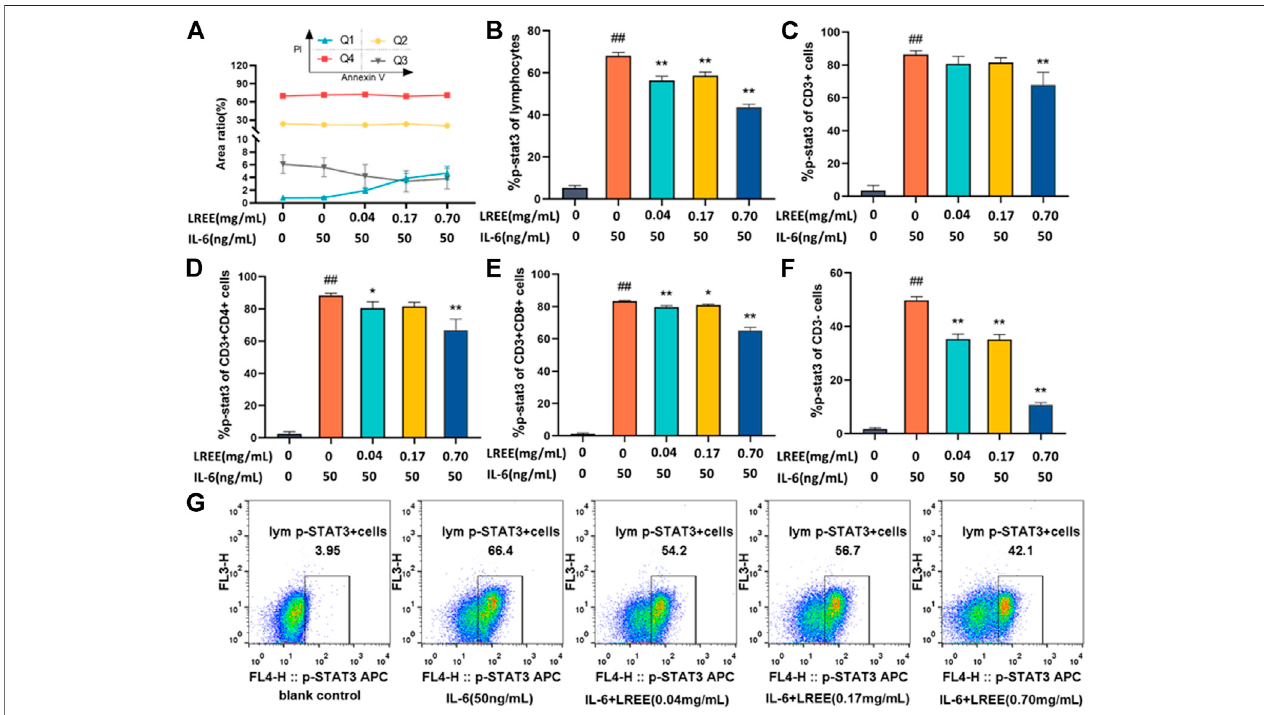
FIGURE7| EffectsofLREEonthephospho-STAT3inducedbyIL-6inlymphocytesanditssubsets( n (cid:2) 3). (A) Thecellviabilityoflymphocytesaftertheintervention of LREE for 3 h. (B – F) Expression of phospho-STAT3 in total lymphocytes, T lymphocytes, CD4 + T cells, CD8 + T cells and CD3 − cells detected by fl ow cytometry. (G) Representativepseudocolordotplotsofthephospho-STAT3oftotallymphocytesby fl owcytometry. # P ＜ 0.05, ## P ＜ 0.01vs.blankcontrol(none-LREEorIL-6-treated) group. * P ＜ 0.05, ** P ＜ 0.01 vs. IL-6